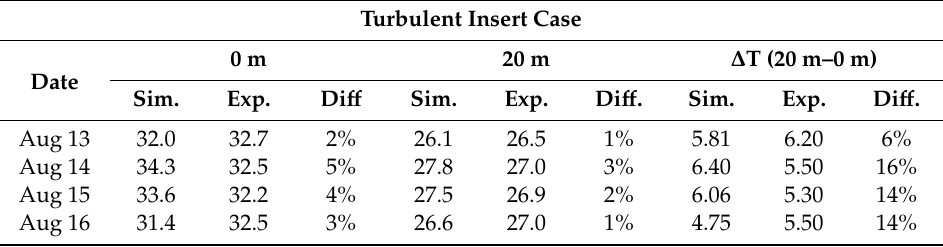
Table 4. Turbulent insert simulation results.